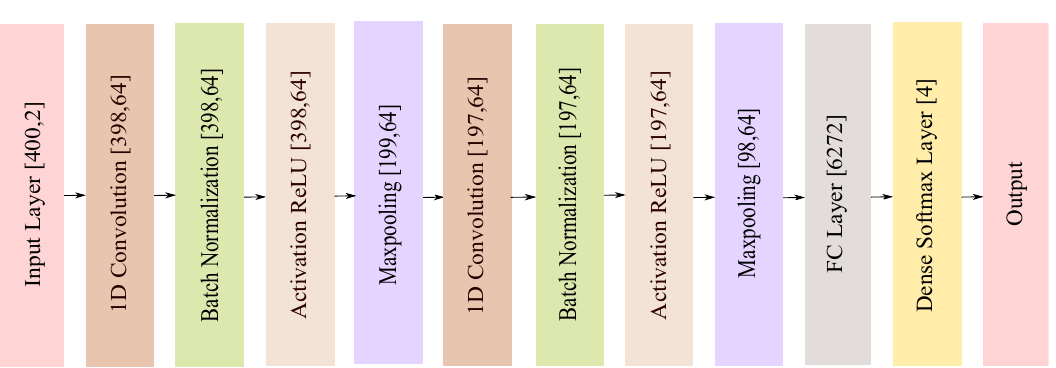
Figure 3: Proposed model architecture containing the two convolution layers followed by the fully connected layer and